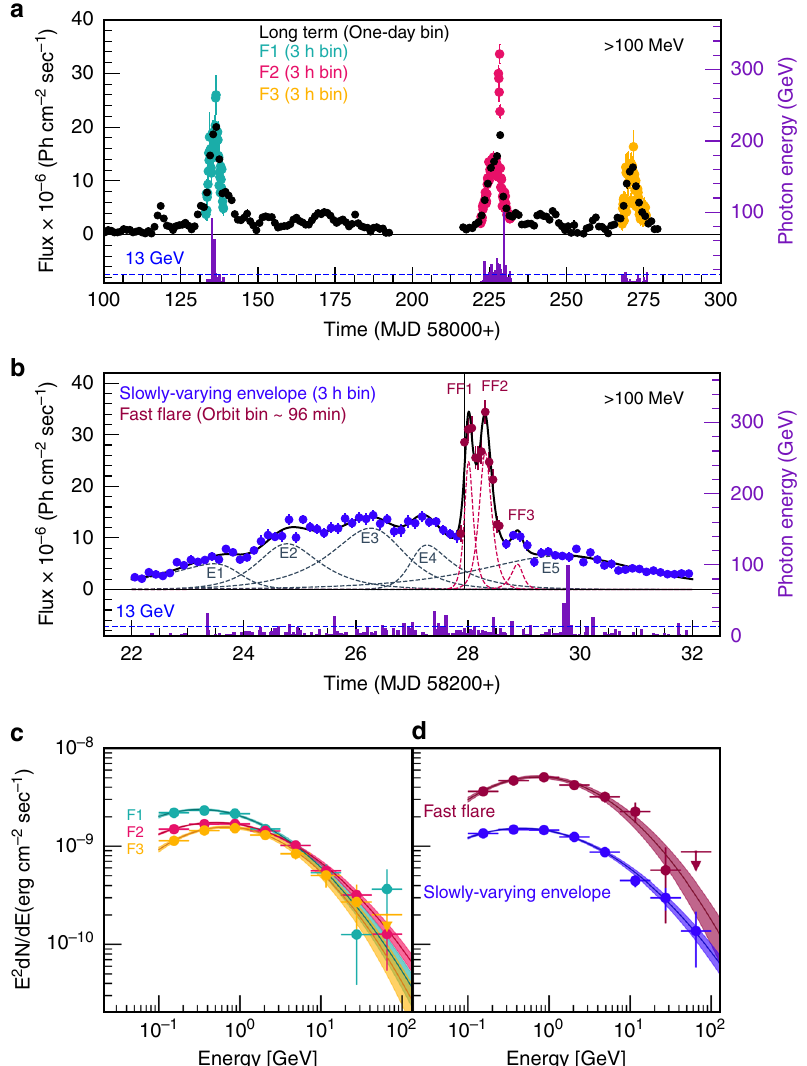
Fig. 1 Gamma-ray fl are characteristics. Long-term light curve and three pronounced fl ares (F1, F2, F3) during MJD 58100 to MJD 58280 from 3C 279 are shown in a and a magni fi ed view of F2 is plotted in b (left Y -axis). A peak-in-peak light curve, previously unknown to fl are activity, is signi fi cantly observed during F2 where two fast fl ares are superimposed on the slowly-varying envelope emission. The energy of each observed photon (right Y -axis) with 99.99% or higher probability of association with 3C 279, is shown as violet bars for all fl ares in a and for F2, in b . Gamma-ray photons above 13 GeV are expected to be absorbed by the UV photons in the BLR due to a high optical depth for pair creation in photon-photon collisions 32 . Hence, the detection of photons with energy above 13 GeV during fl ares, strongly suggests that gamma-ray emission must have originated outside of the BLR. The spectral energy distributions (SED) of F1, F2, and F3 are plotted in c whereas d represents the SEDs of the slowly varying envelope (blue) and fast fl are component (maroon) observed during F2. The error bars in the light curve and SEDs represent 1 σ